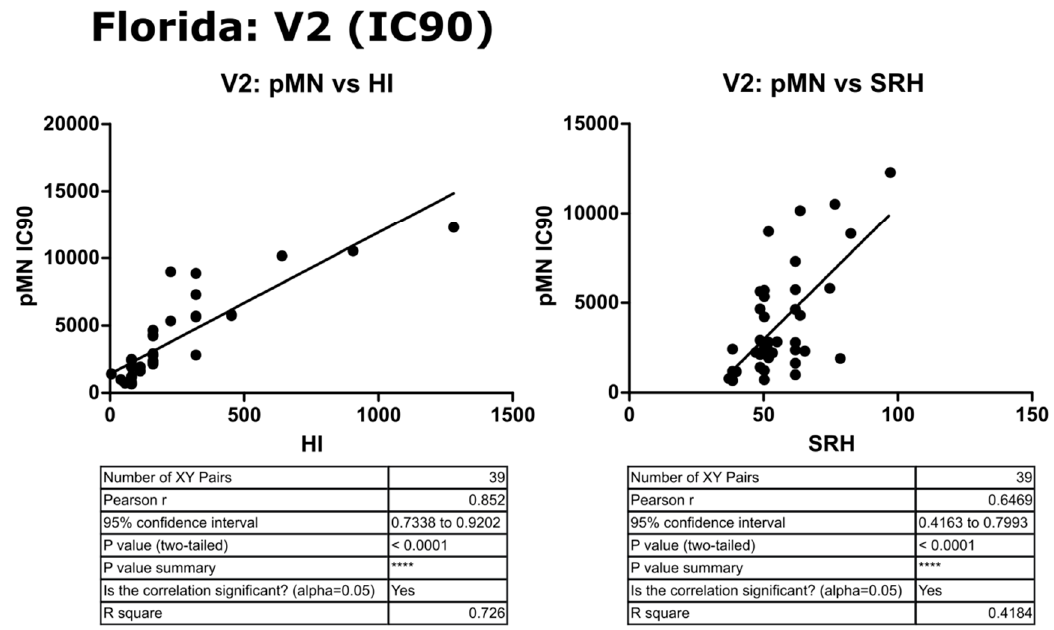
Figure 15. Correlation between pMN (IC 90 ) with SRH and HI mean V2 values, assayed against B/Florida/4/2006 PV. Pearson’s two-tailed analysis performed using GraphPad prism. Strong correlation was observed between IC 90 antibody titres and HI or SRH, with Pearsons r values of 0.85 and 0.64, respectively. p ≤ 0.0001 = ****.